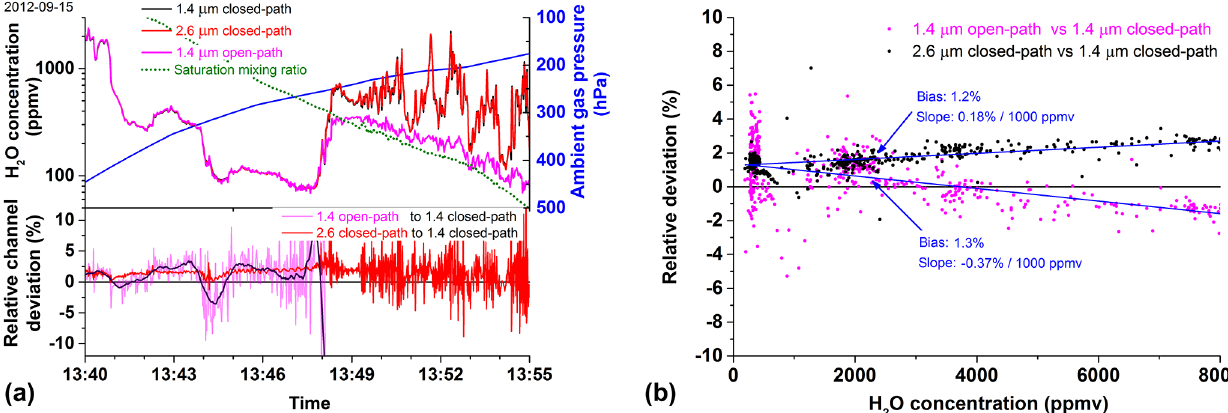
Figure 10. HAI measurement on board HALO during the TACTS/ESMVal campaign. Left: the flight profile shows a 15 min section of a slow ascent from the lower troposphere to the upper troposphere. The first part (under clear-sky condition) can be used to perform an absolute in-flight accuracy comparison of HAI’s measurement channels; the second part demonstrates a multi-phase H 2 O measurement. For further explanations of all signals and visible effects, see text. Right: the scatterplot displays on the x axis the water vapor concentration measured by the 2.6µm closed-path cell and on the y axis the relative deviation of the 1.4µm closed-path cell (and the 1.4µm open-path cell) from the 2.6µm closed-path cell measurements. This scatterplot contains all data from 13:40 to 13:48 shown in the left